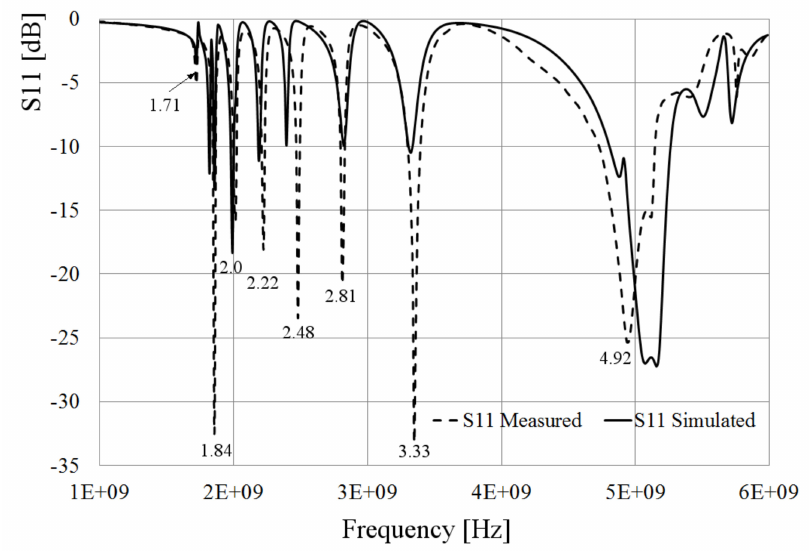
Figure 16. Comparison of simulated and measured S11